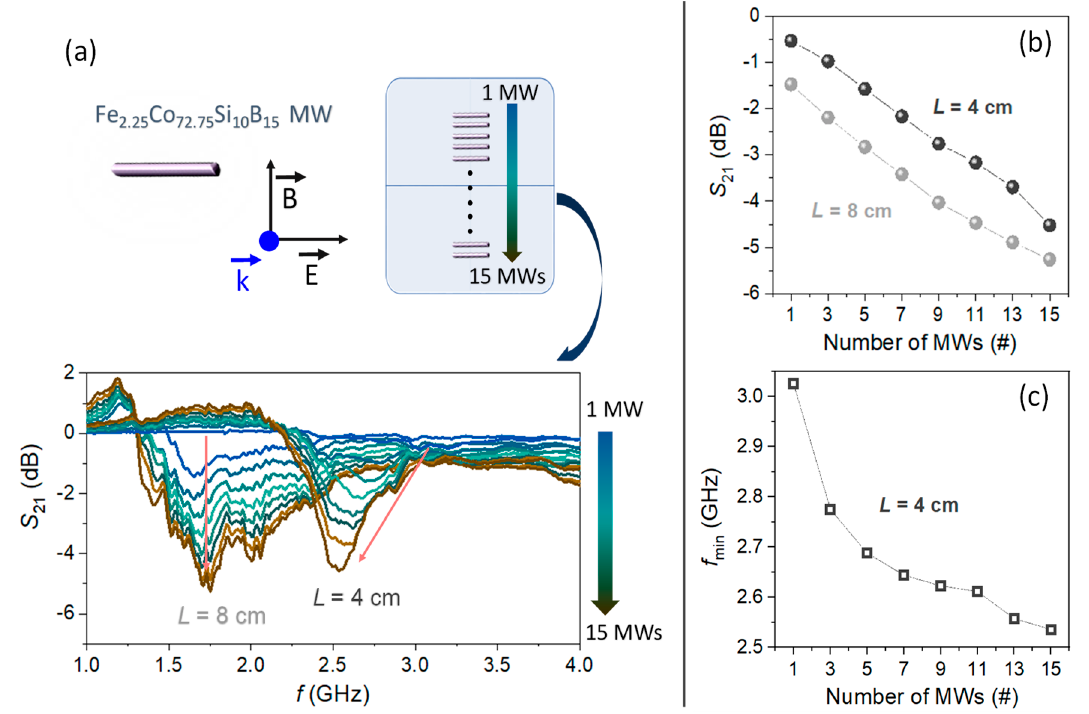
Figure 3. ( a ) Top part illustrates the sensing array platform layout from 1 to 15 Co-based MWs. Bottom part shows the S 21 transmission coefficients in the L and S microwave spectral GHz regions obtained for two linear arrays composed of Co-based MWs with a length of 4 cm and 8 cm from 1 to 15 MWs. ( b ) S 21 minimum value and ( c ) f min as a function of the number of 4 cm MWs in the array collected from the results showed in the bottom of ( a ).